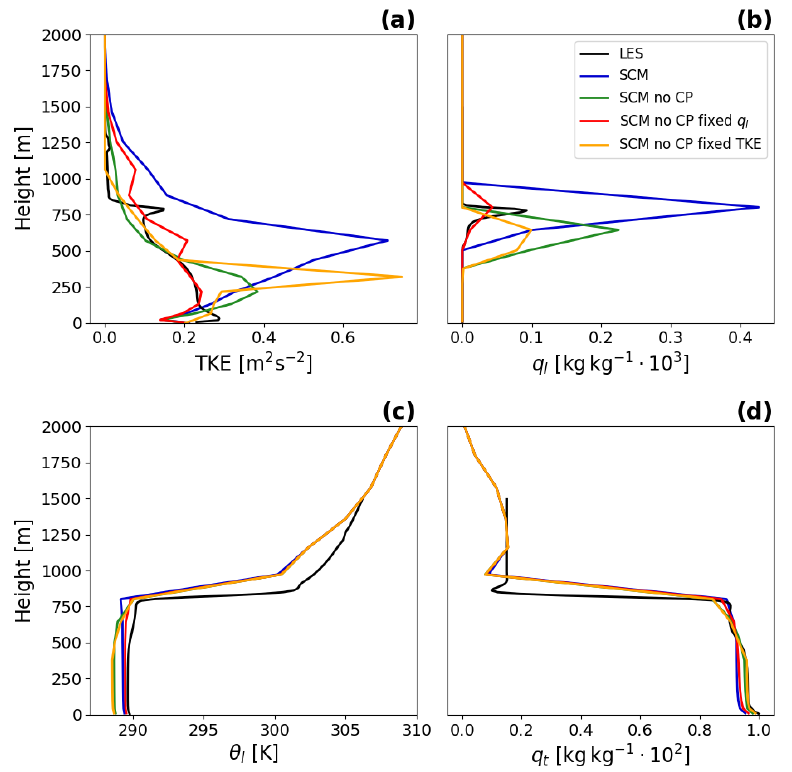
Figure 7. As in Figure 5, but one-hour mean vertical profiles of TKE ( a ), liquid water content ( b ), liquid water potential temperature ( c ), and total specific water content ( d ) after 5 h of